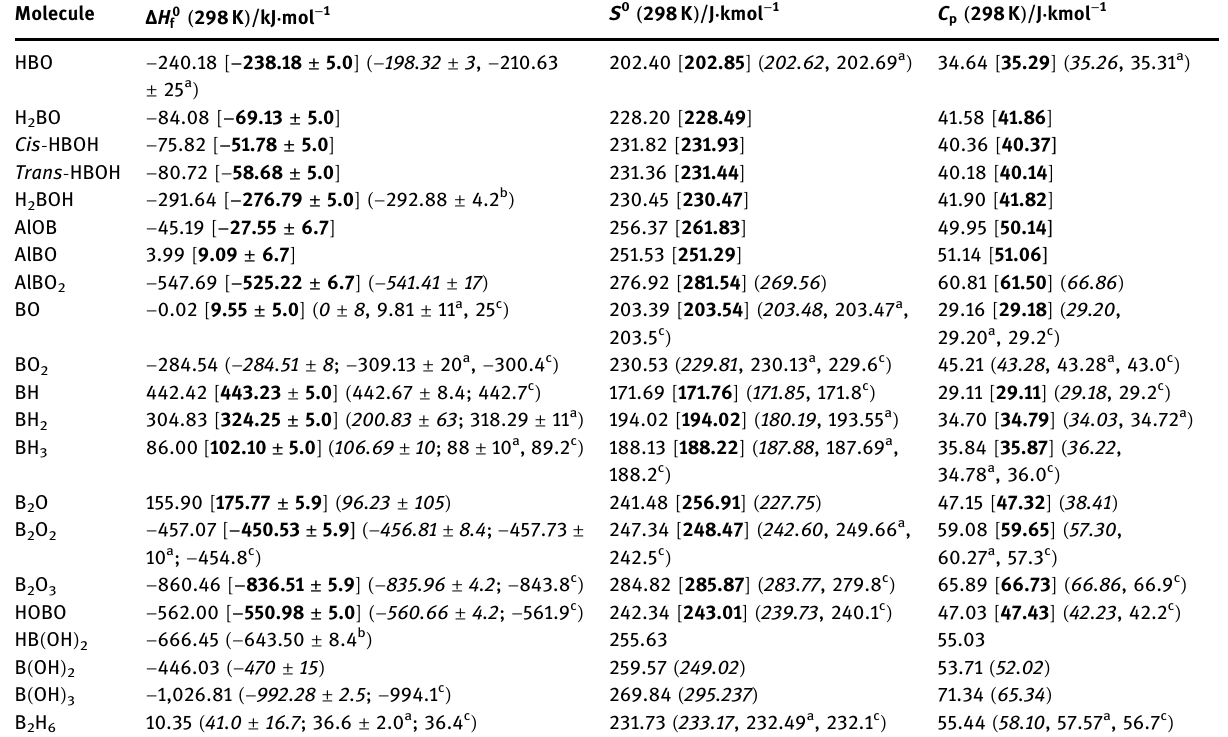
Table 1: Thermodynamic data calculated by M06 - 2X, CCSD ( T ) [ bold in brackets ] , and literature values ( in parentheses: JANAF ( italic ) ([ 49 ]) and others